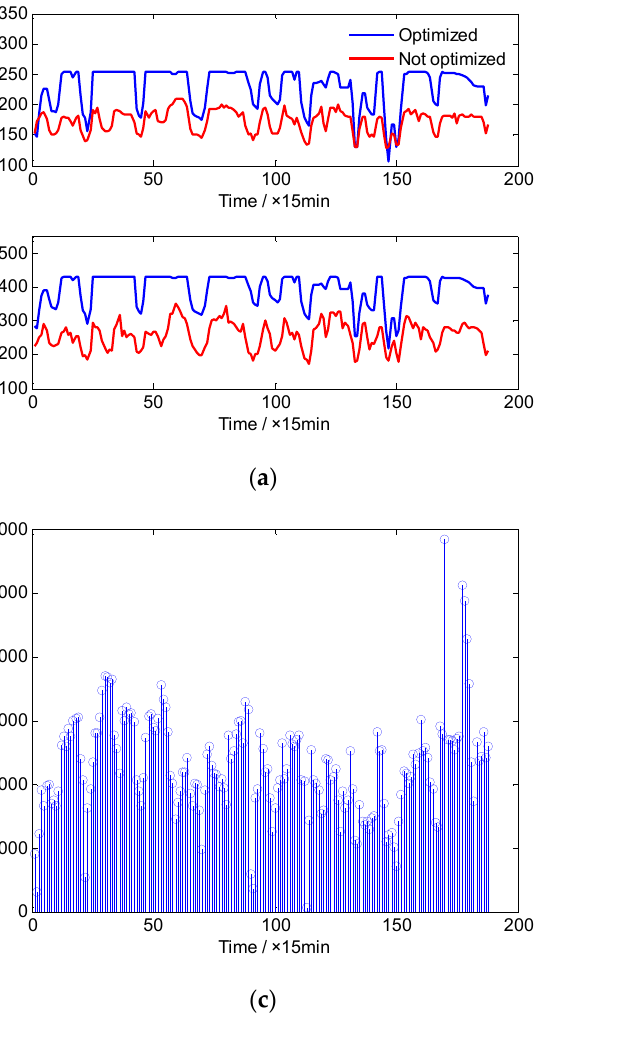
Figure 10. Comparison before and after optimization under mode 3 (HBP + EH) working conditions. ( a ) Electricity and heat load of HBP unit. ( b ) EH Electricity and heat load of EH unit. ( c ) Coal saving before and after optimization. ( d ) Spatial distribution of coal saving